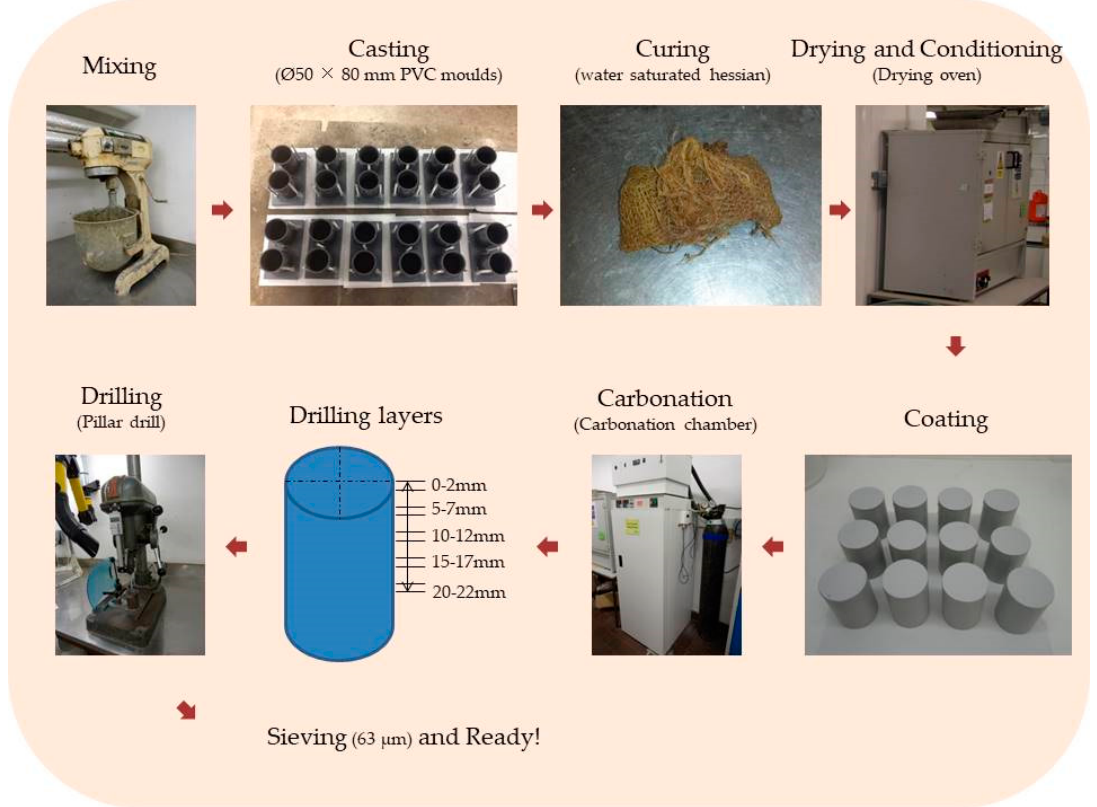
Figure 2. Flowchart illustrating the sample preparation procedure.